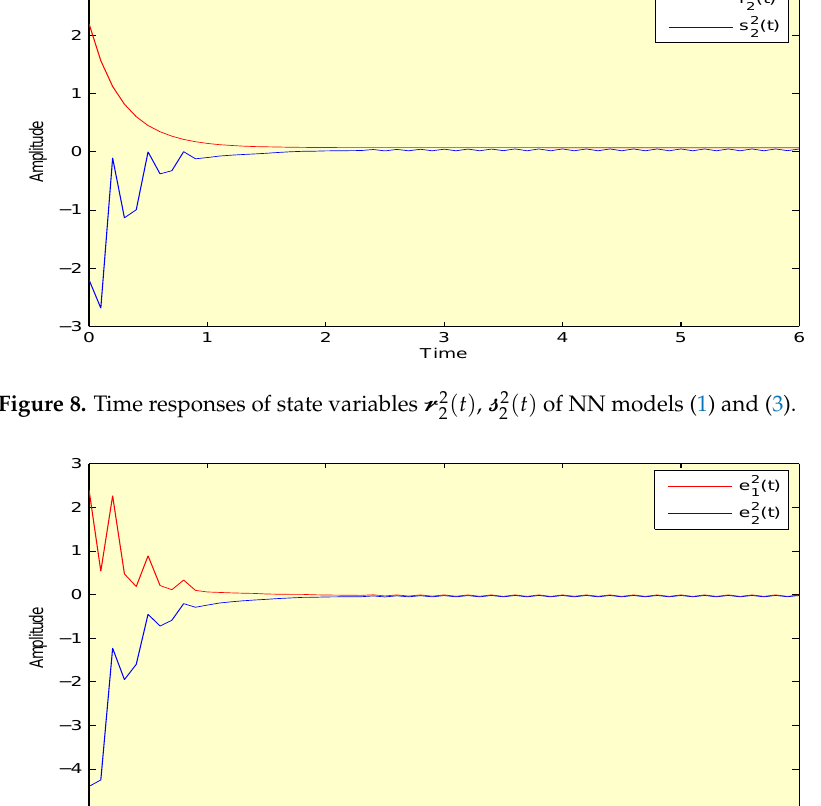
( t ) , (cid:115) 2 ( t ) of NN models (1) and (3). 1 1